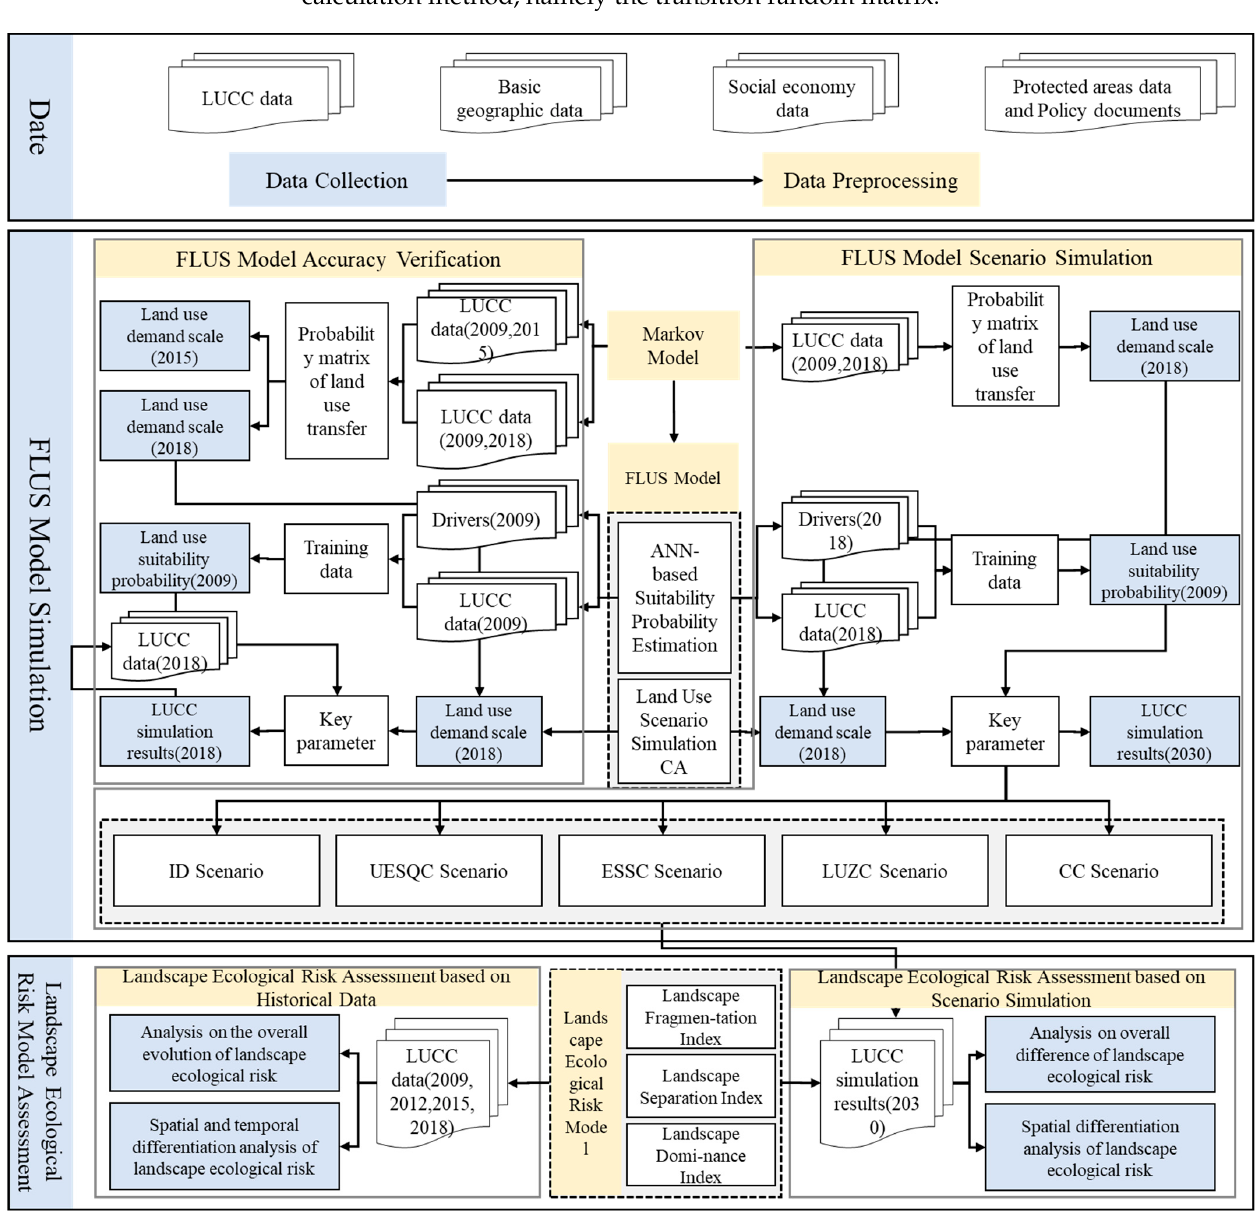
Figure 2. Framework of This Study.